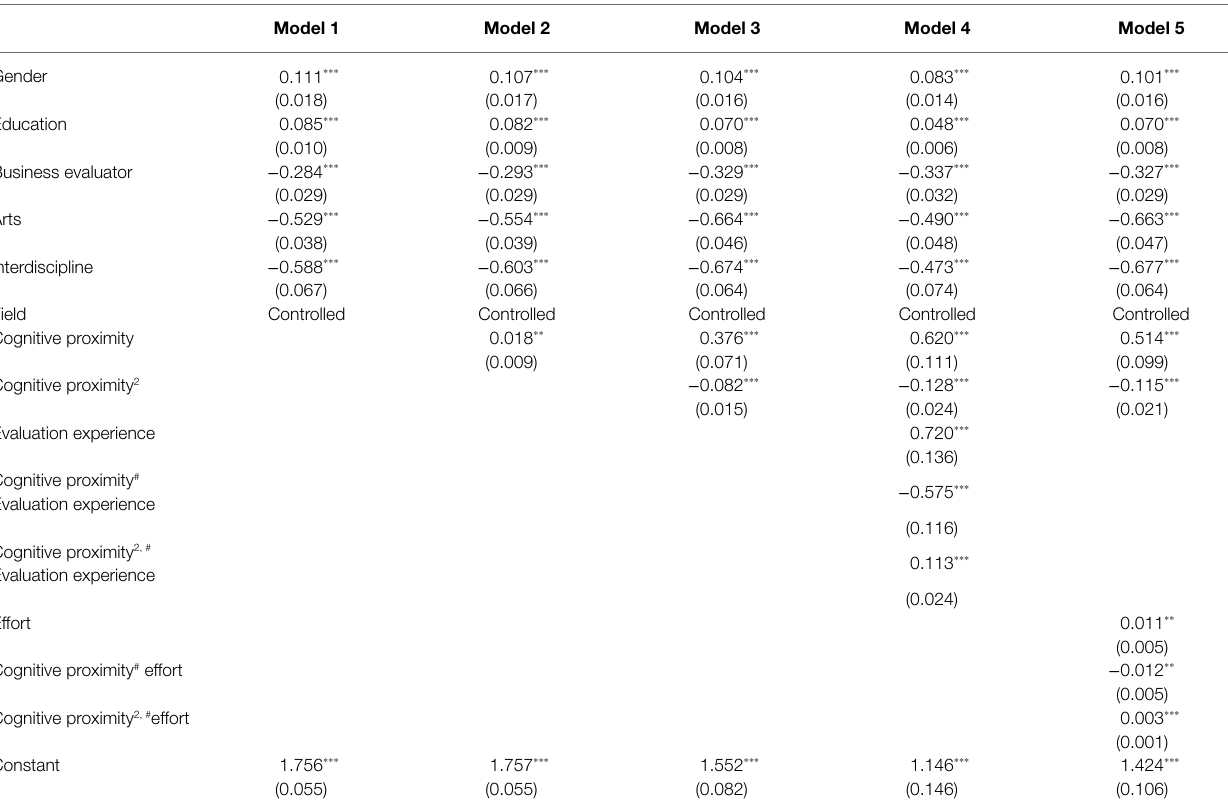
TABLE 4 | Negative Binomial Regression within